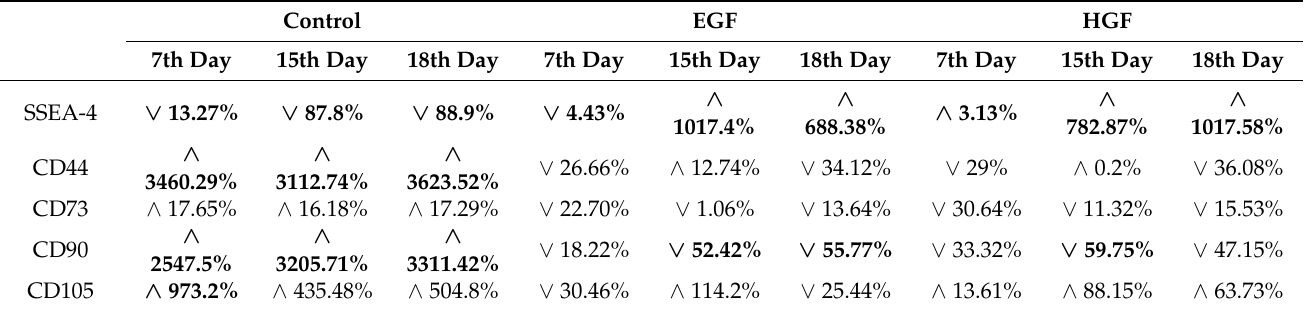
Table 3. Percentage change in the number of cells expressing pluripotency and mesenchymal surface markers in the control culture (compared with 72 h) and in differentiating cultures (EGF, HGF) relative to the respective control cultures.